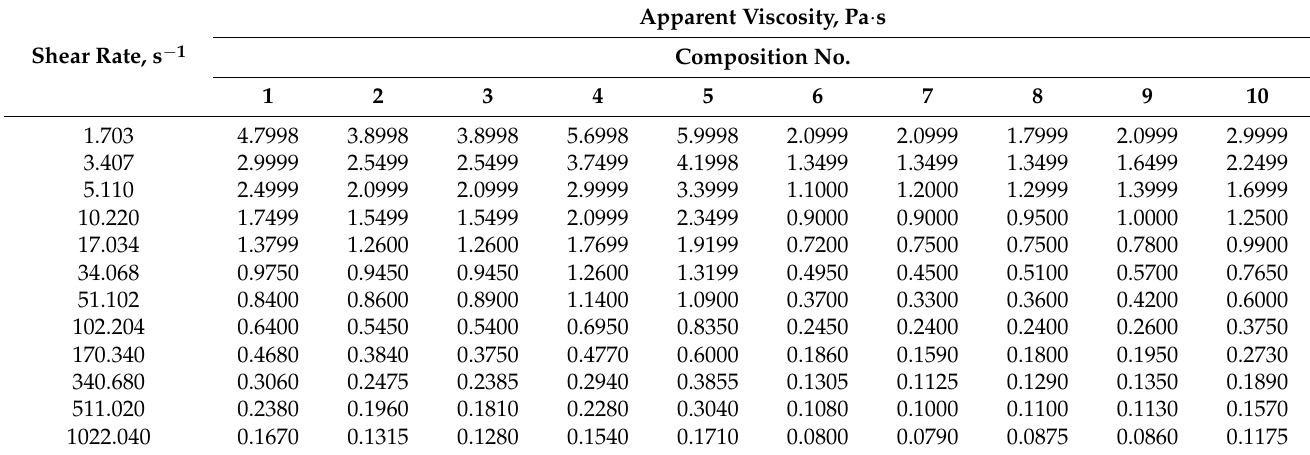
Table 8. Results of measurements and calculated values of apparent viscosity for slurries.